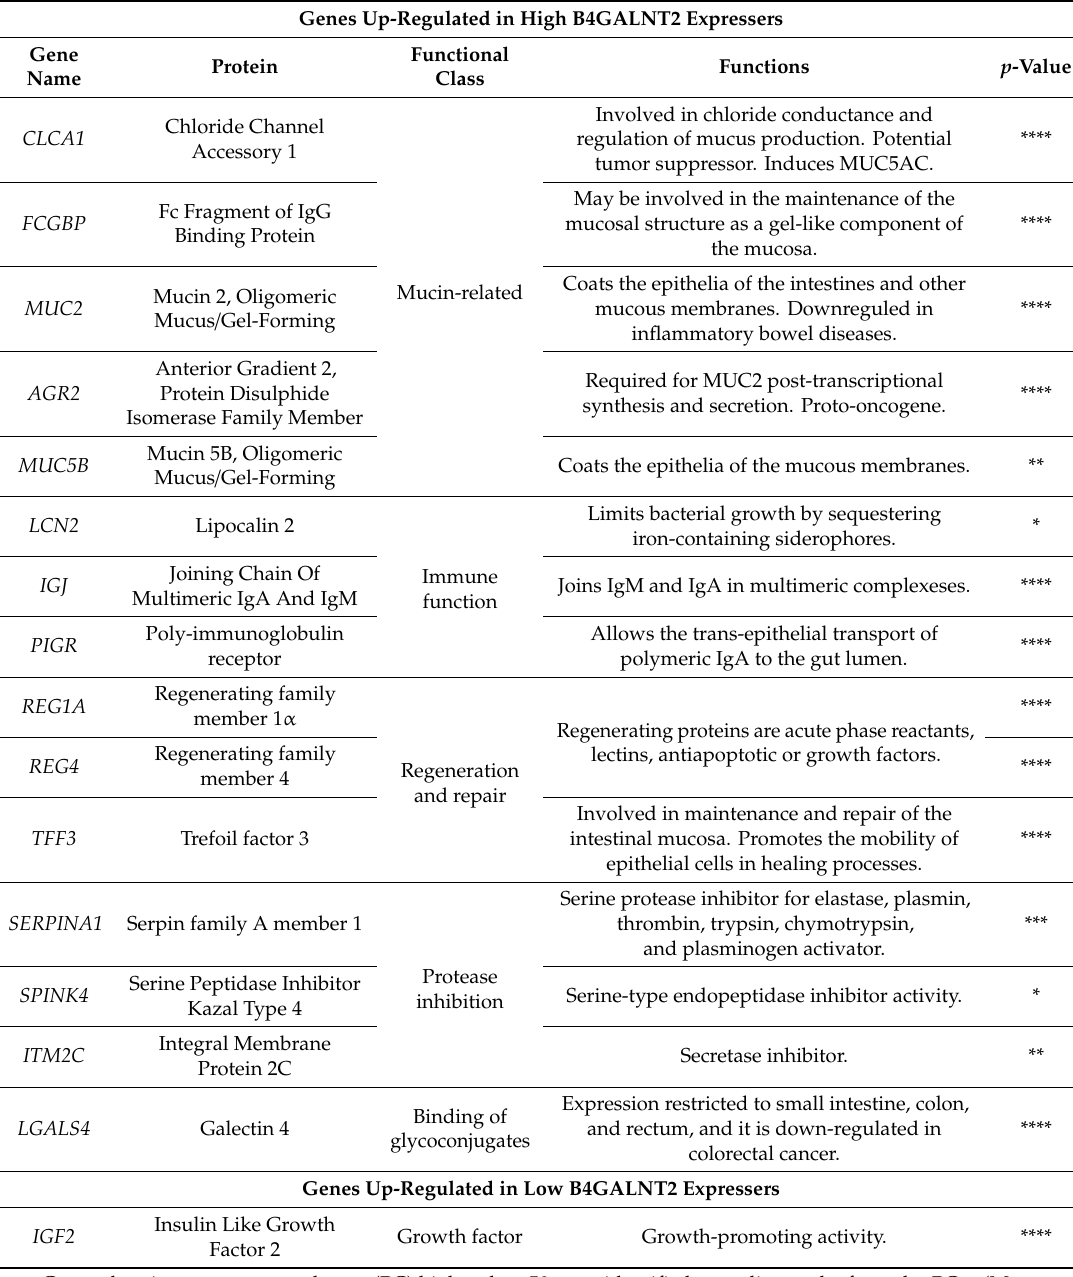
Table 1. Genes modulated in high / low B4GALNT2